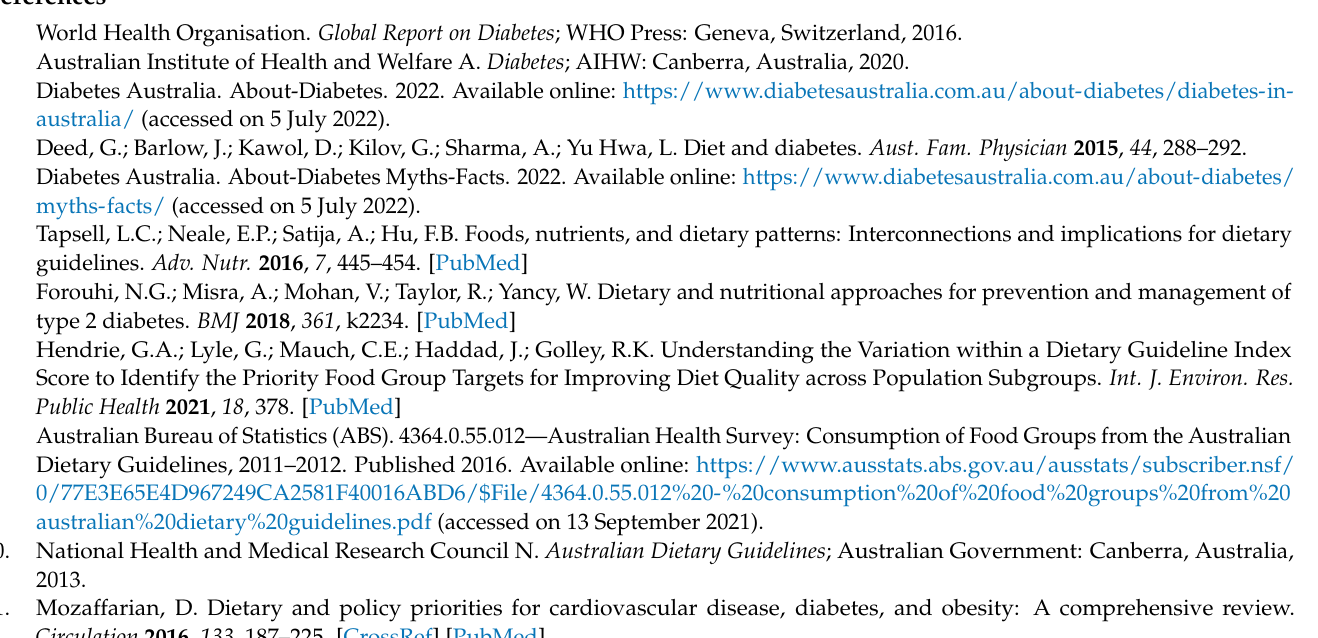
Table S8: Results from reviews on cardiovascular markers among different dietary patterns: Dietary interventions versus control diets difference in cardiovascular outcome. Table S9: Conclusions and quality appraisal of dietary patterns for